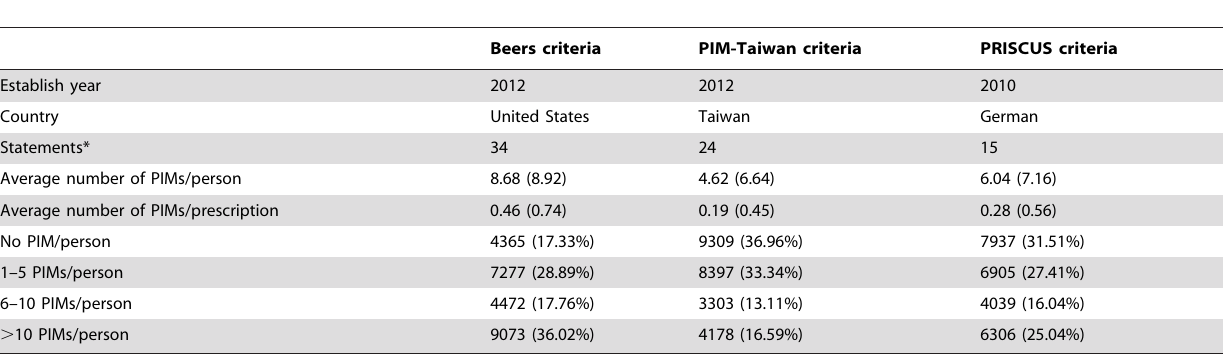
Table 2. Characteristics of the three sets of explicit criteria and their performance in detecting potentially inappropriate medications.